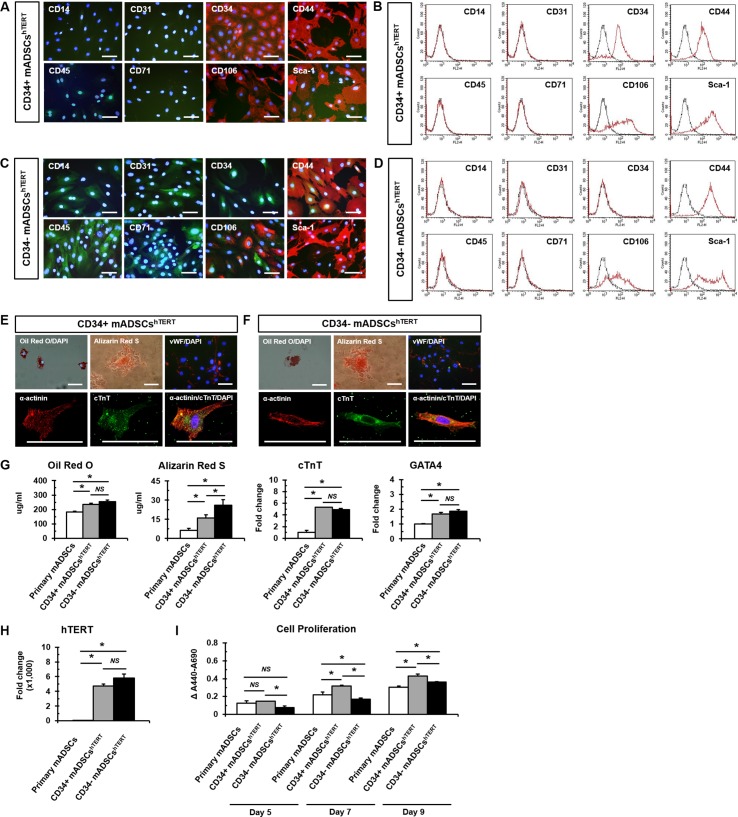
hTERT-immortalized mADSCs exhibit multi-lineage differentiation capacity.Immunofluorescence staining (A) and flow cytometric analysis (B) of CD34+ mADSCshTERT show positive expression of CD34, CD44, CD106, and Sca-1. Immunofluorescence staining (C) and flow cytometric analysis (D) of CD34- mADSCshTERT show positive expression for CD44, CD106, and Sca-1. CD34+ (E) and CD34- (F) mADSCshTERT exhibit adipogenic (Oil Red O positive), osteogenic (Alizarin Red S positive), endothelial (vWF positive), and cardiomyogenic differentiation potentials (α-actinin positive and cTnT positive). Nuclei were stained with DAPI (blue). (G) Adipogenic differentiation of primary mADSCs, CD34+, and CD34- mADSCshTERT was visualized by Oil Red O staining and was quantified by measuring the absorbance at 500 nm in a microplate reader. Osteogenic differentiation of primary mADSCs, CD34+, and CD34- mADSCshTERT was visualized by Alizarin Red S staining and was quantified by measuring the absorbance at 405 nm in a microplate reader. Cardiomyogenic differentiation of primary mADSCs, CD34+, and CD34- mADSCshTERT was analyzed by quantitative real-time PCR with primers for cardiomyocyte-specific markers (cTnT and GATA4). Data shown represent mean ± SD from three independent experiments (*p < 0.05; NS, not significant). (H) Real-time PCR was performed to detect transduced hTERT transcripts in CD34+ and CD34- mADSCshTERT. Primary mADSCs were used as a negative control. Data shown represent mean ± SD from three independent experiments (*p < 0.05; NS, not significant). (I) Cell proliferation of primary mADSCs, CD34+, and CD34- mADSCshTERT was evaluated by WST-1 assay at 5, 7, and 11 days after seeding. Data shown represent mean ± SD from three independent experiments (*p < 0.05; NS, not significant). Scale bars in A, C, E, and F = 100 μm.